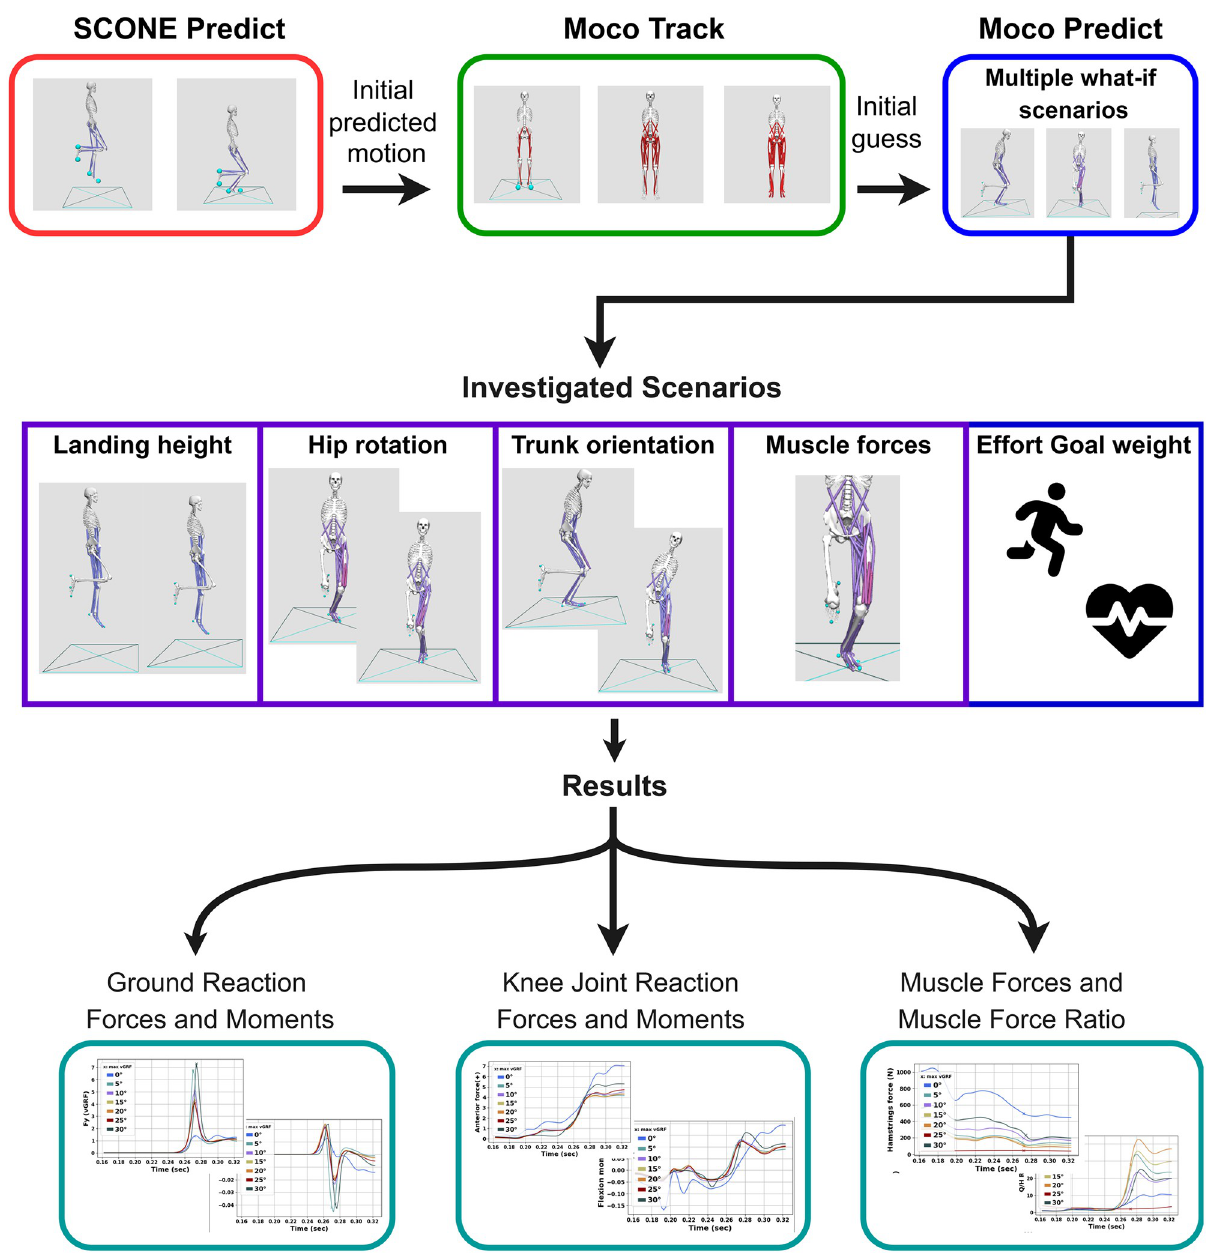
Fig 1. Overview of the proposed simulation pipeline. In this figure, the adopted workflow for this work is presented. In the first layer, the implemented methods and software tools used in this work are presented. The second layer illustrates all the examined scenarios. Finally, in the third layer the measured parameters that are related to ACL injuries during single-leg landings are